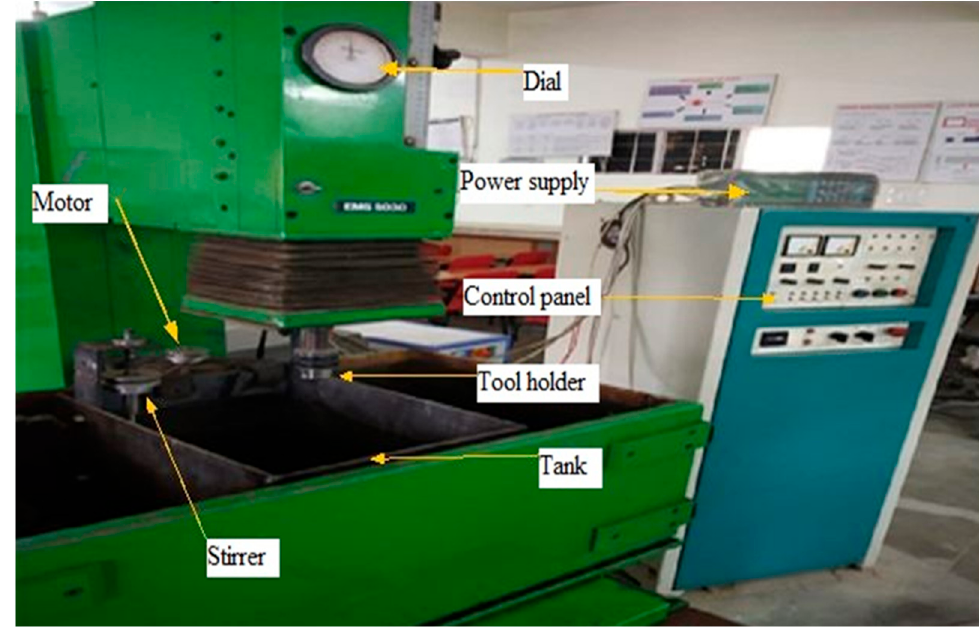
Figure 2. Pictorial View of Powder Mixed EDM Setup.